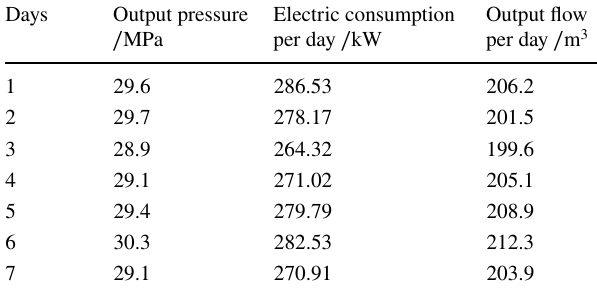
Table 3 Records of the injection test in